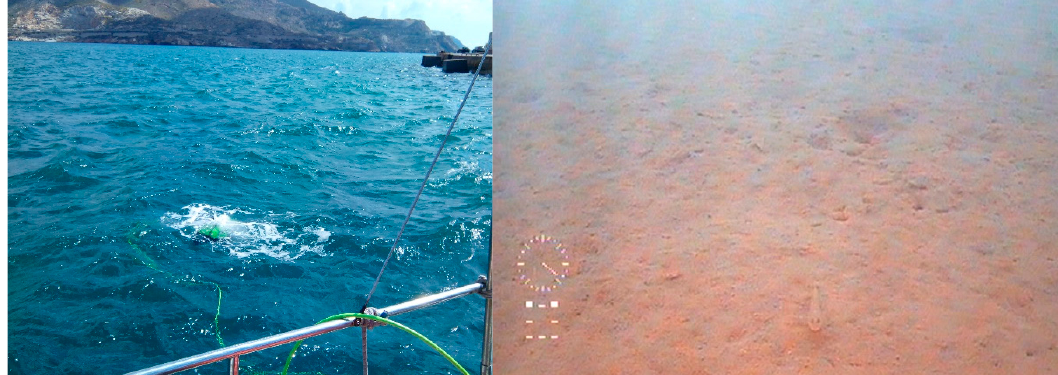
Figure 5. Robot on deployment ( left ) and an image of the seabed ( right ).